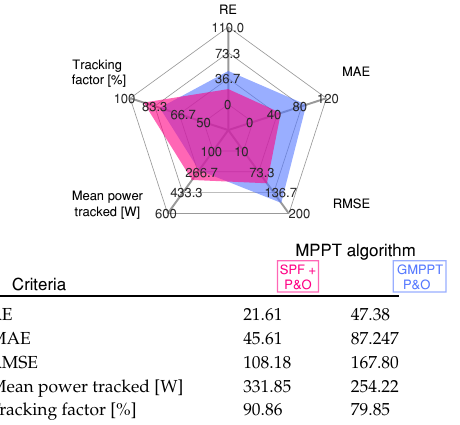
Figure 12. Comparative analysis of the MPPT methods for Scenario 4 shown in Figure 11.